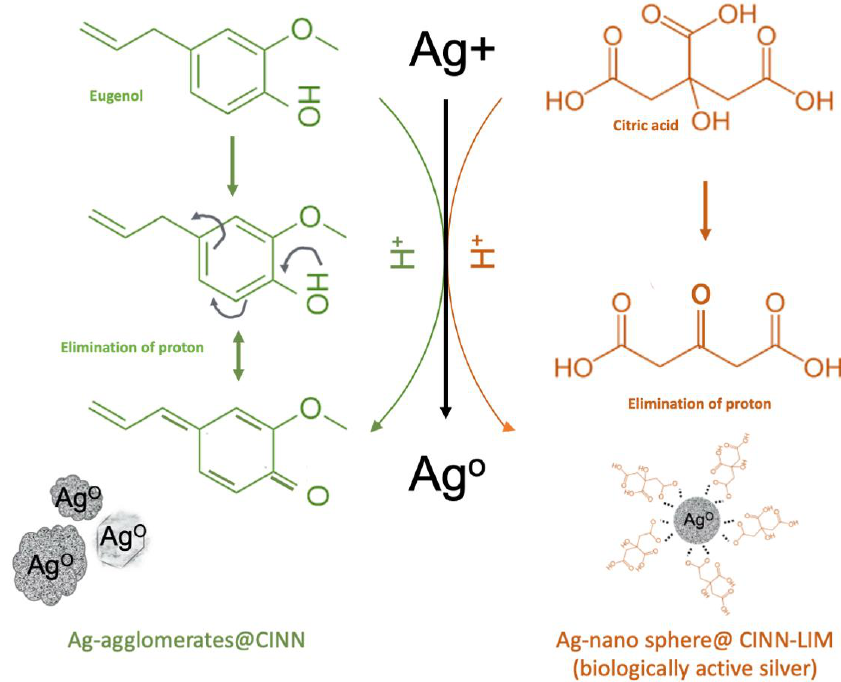
Figure 1. Possible reduction mechanism of silver in the presence of cinnamon and lime extract followed by capping.